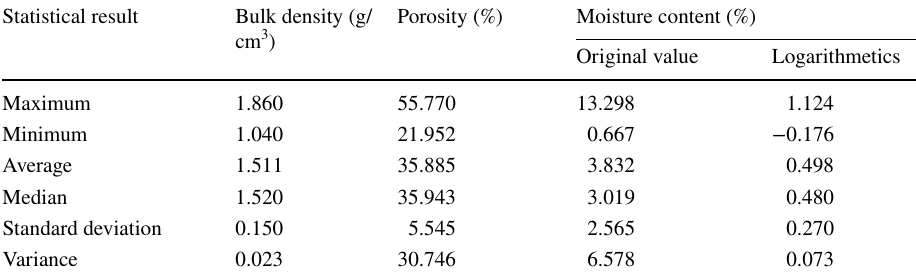
Table 2 Soil physical properties